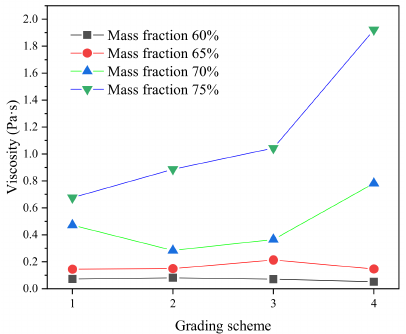
Figure 8. Effect of particle size grading distribution on plastic viscosity.